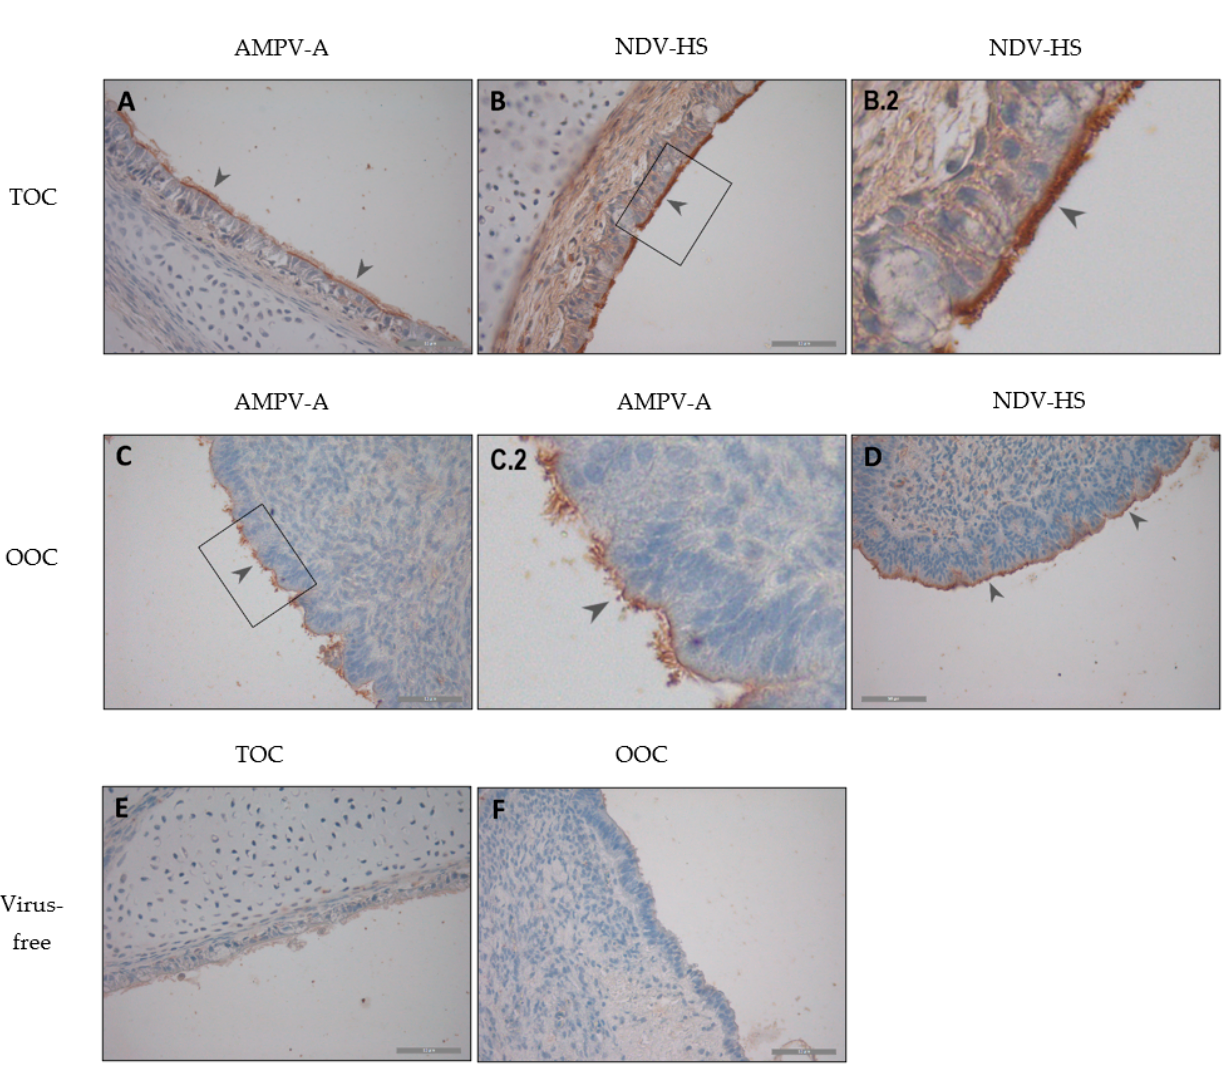
Figure 3. Antigen detection of AMPV-A ( A , C ) and NDV-HS ( B , D ) in TOCs ( A , B ) and OOCs ( C , D ) through immunohistochemistry . Brown staining indicates virus-infected cells. ( A ) TOC infected with AMPV-A, ( B ) TOC infected with NDV-HS, ( C ) OOC infected with AMPV-A, ( D ) OOC infected with NDV-HS, ( E ) virus-free TOC, ( F ) and virus-free OOC—all at 48 hpi. Arrowheads mark specific viral antigen staining, and black boxes visualize zoomed-in areas (shown in B.2 , C.2 ). The scale bar was 50 µm.